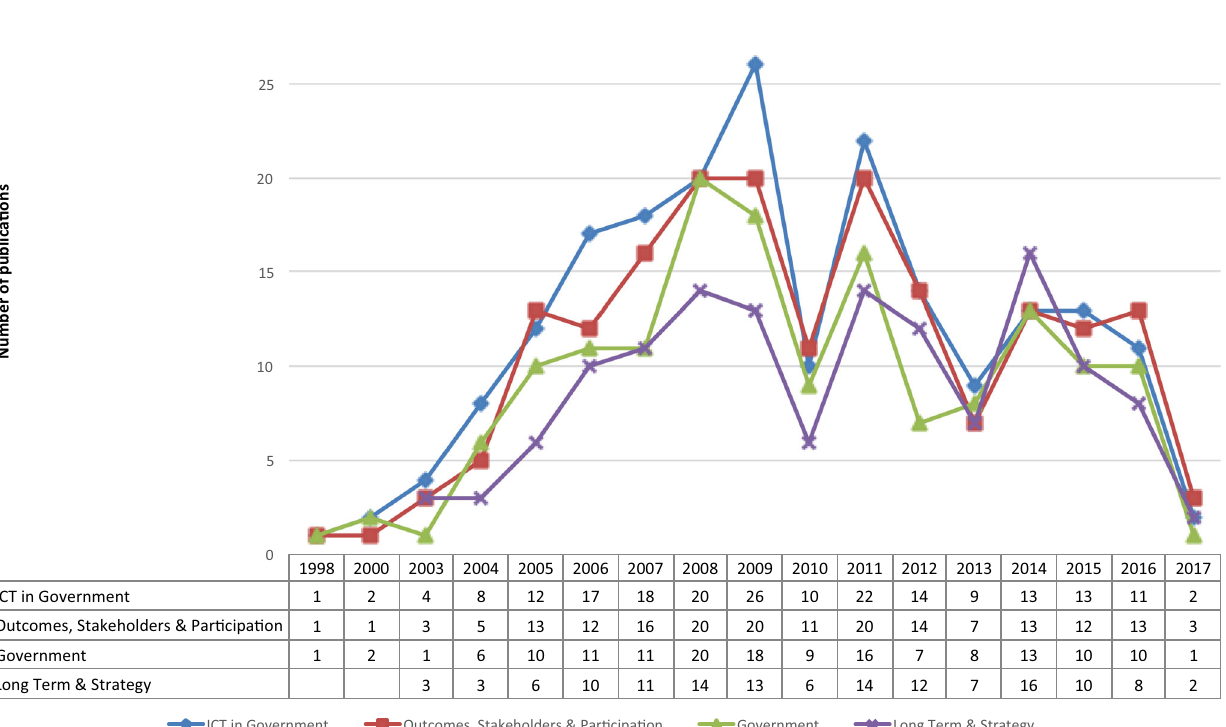
Fig. 12 Keywords groups (based on use of terms in Abstracts) per year of publication